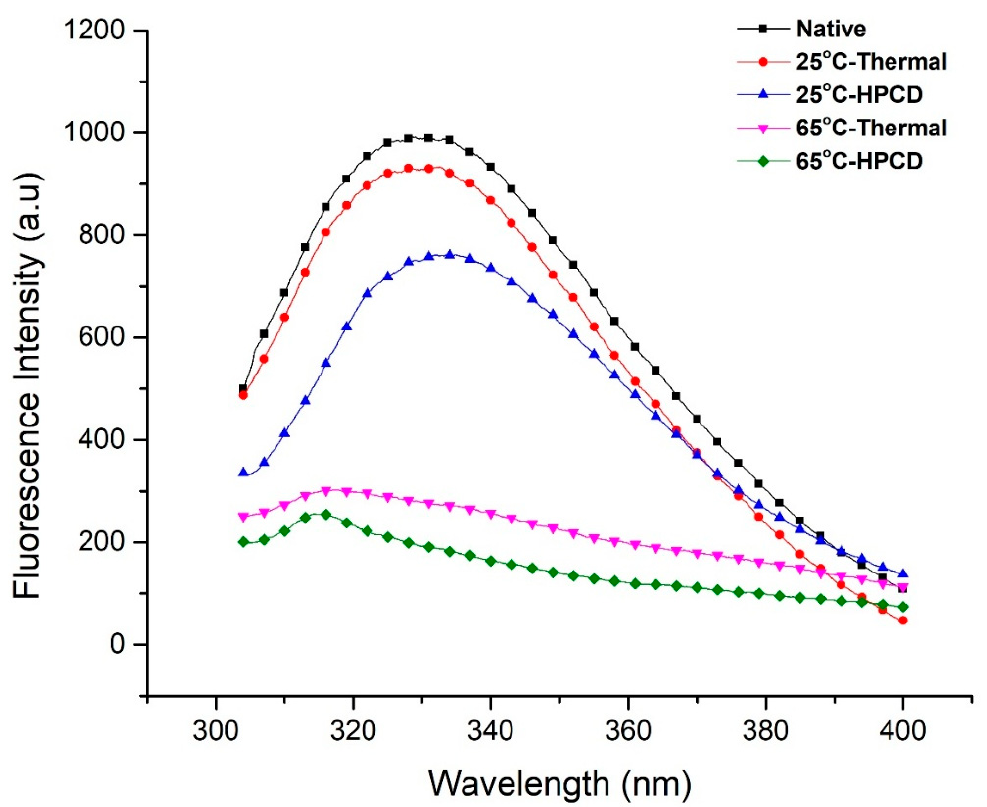
Figure 5. Fluorescence spectra of PPO during thermal treatment at 25 and 65 °C and HPCD treatment at 25 and 65 °C and its correlation analysis during PPO inactivation.